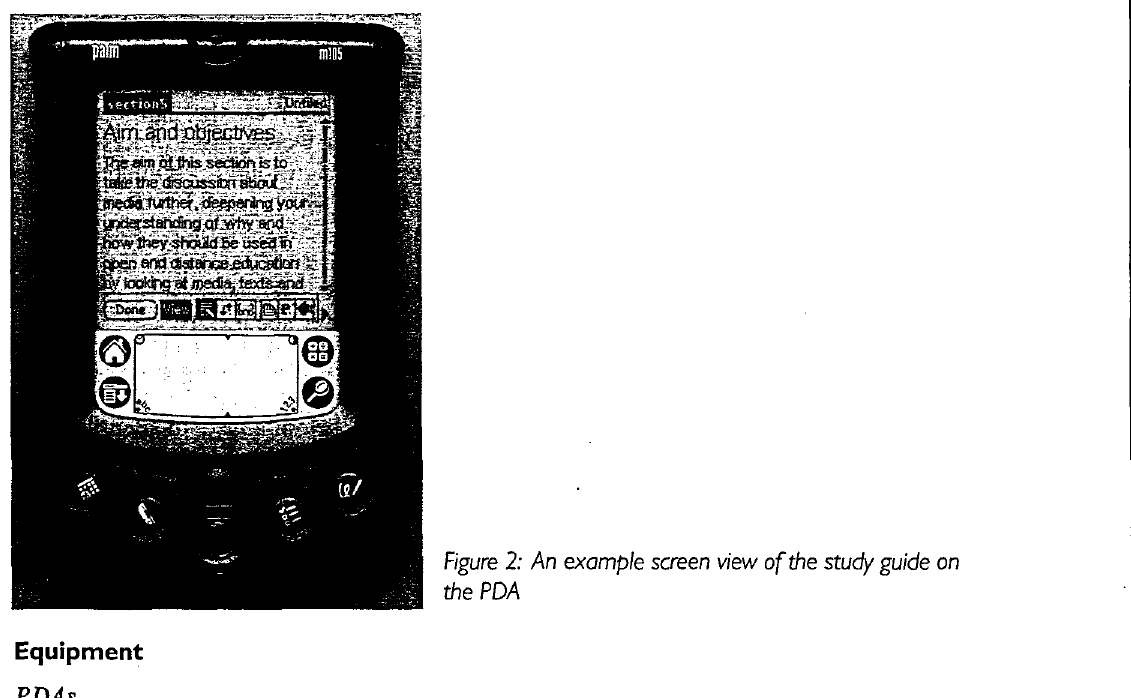
Figure 2: An example screen view of the study guide on the